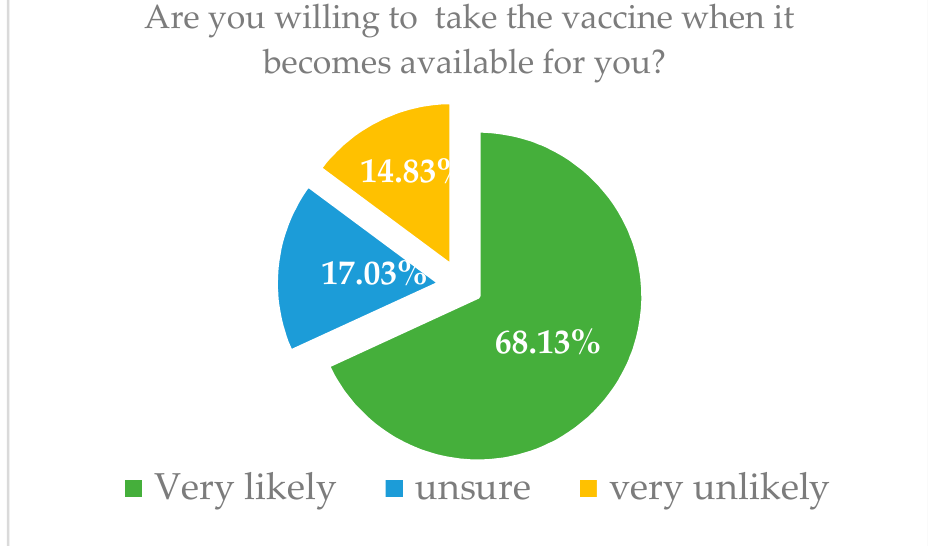
Figure 6. Intent to vaccinate against COVID-19 among all the participants.